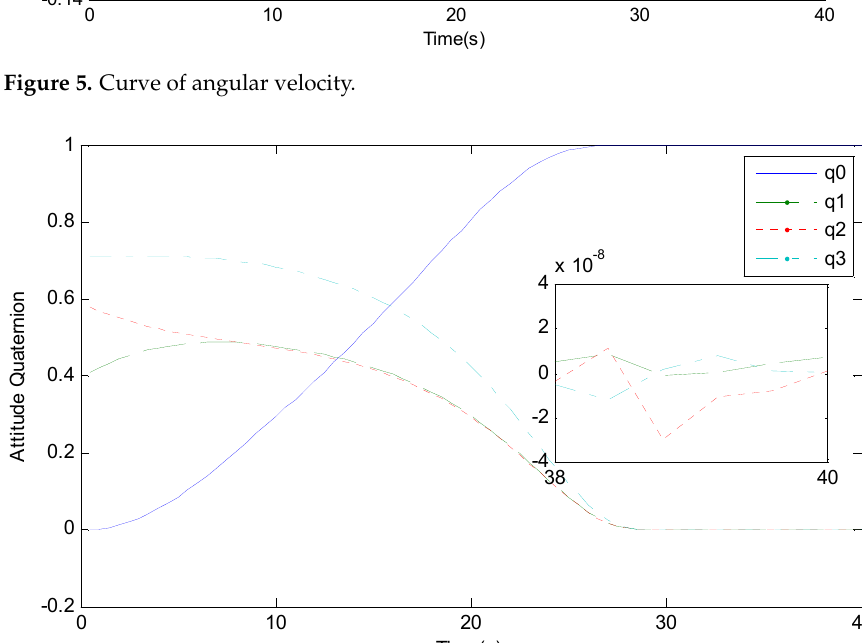
Figure 6. Curve of attitude quaternion.